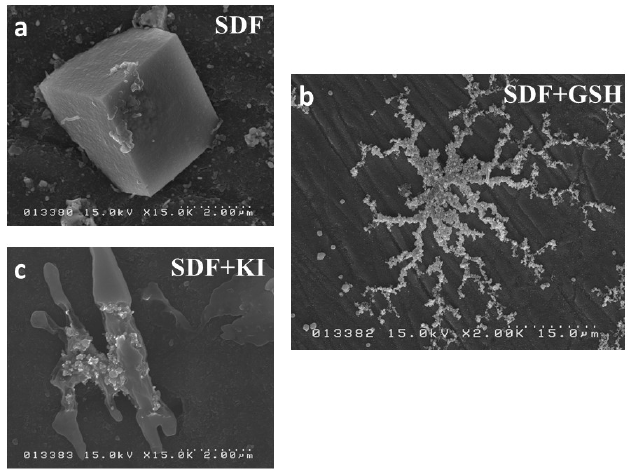
Figure 7. SEM image for the pattern of crystal formation: ( a ) SDF group; ( b ) SDF + GSH group; and ( c ) SDF + KI group.